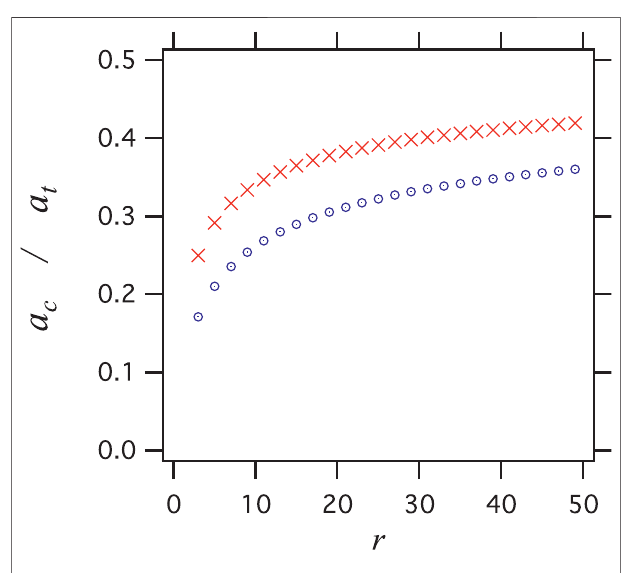
FIGURE 8 | Critical parameters a c and a t as functions of group size r